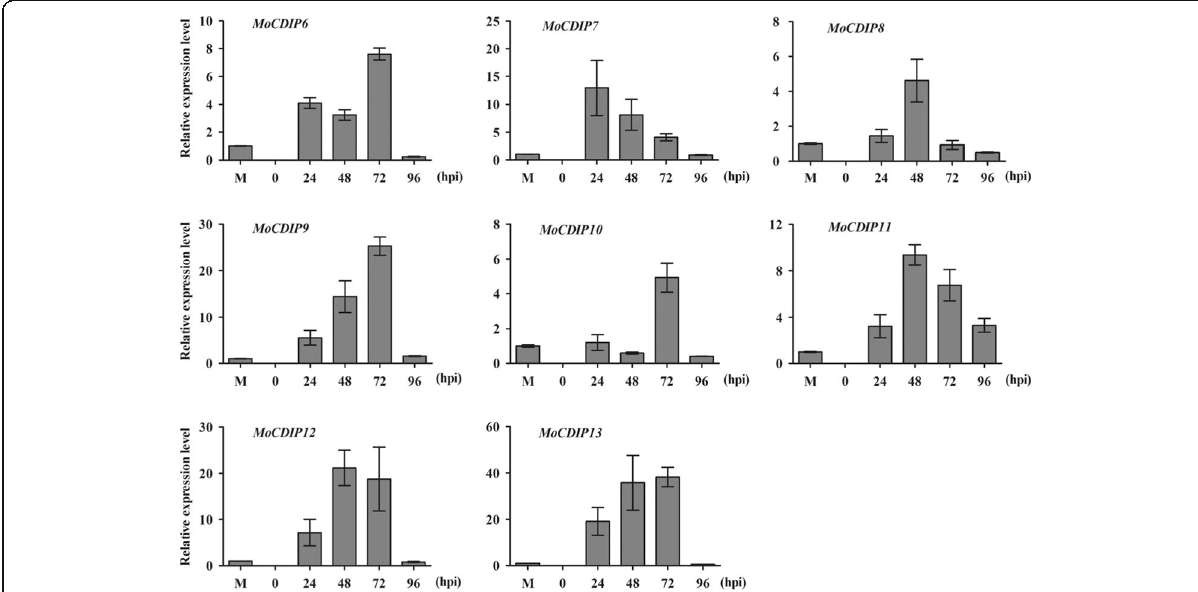
Fig. 2 qRT-PCR confirmation of in planta expression pattern of the eight MoCDIP genes. Total RNA samples extracted from M. oryzae mycelium (M), and from blast-infected rice leaves at 0, 24, 48, 72, or 96 hpi were subjected to